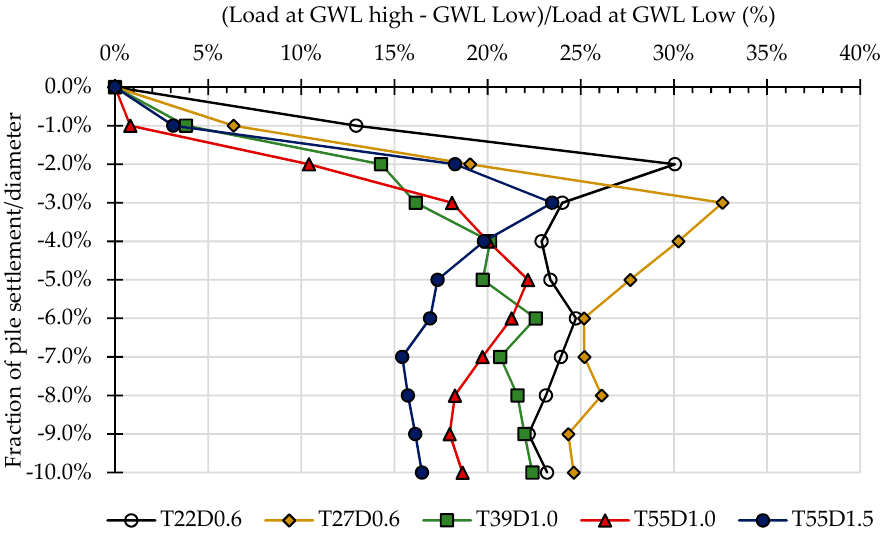
Figure 14. Fraction of pile load reduction in each pile settlement.